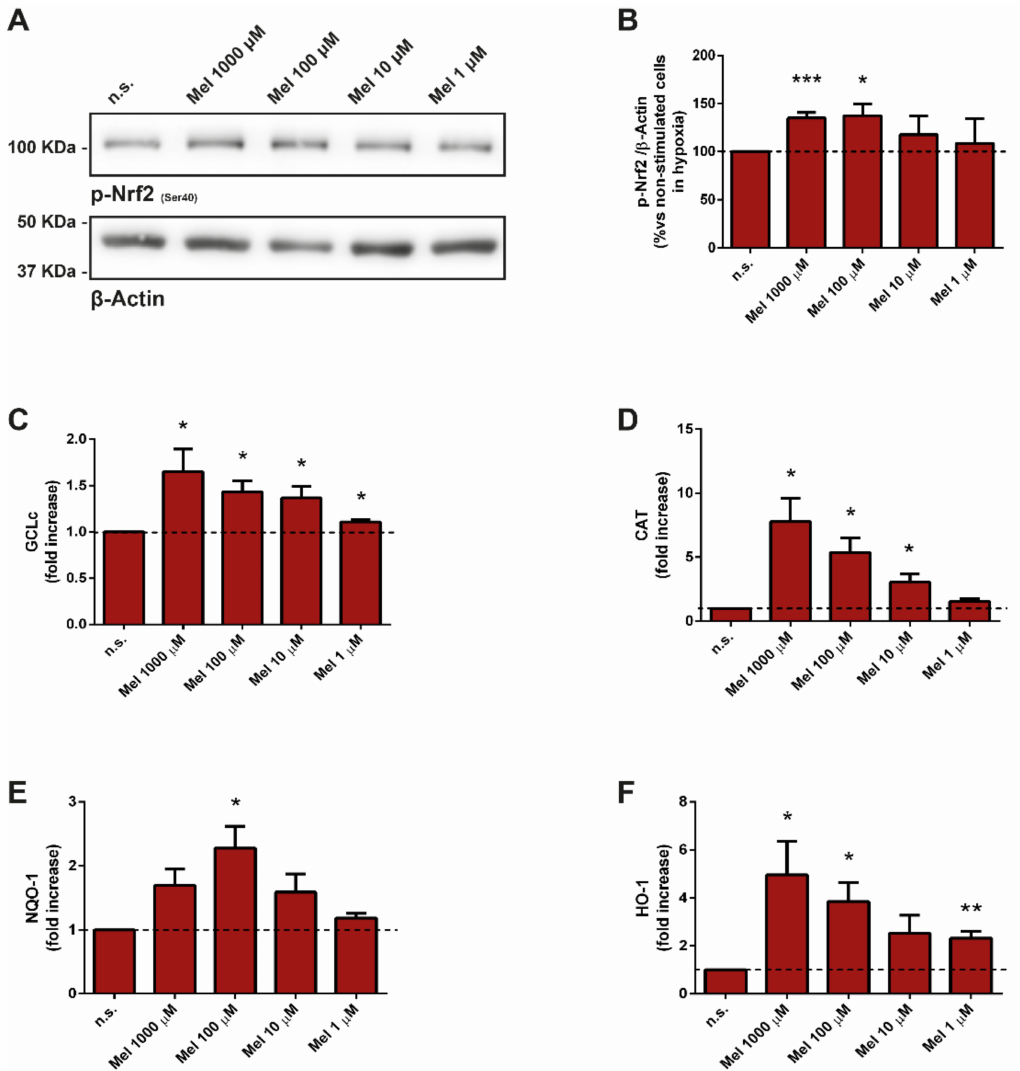
Figure 2. Effect of melatonin on Nrf2-phosphorylation and on Nrf2-regulated enzymes. PSC were incubated with melatonin (1000 µ M, 100 µ M, 10 µ M, or 1 µ M) during 4 h under hypoxia. ( A ) Blots showing the effect of melatonin on the phosphorylation of Nrf2. Western blotting analysis was carried out using a specific antibody against the protein. The levels of β -actin were employed as controls to ensure equal loading of proteins. ( B ) The bars show the quantification of protein phosphorylation. A horizontal dashed line represents the value observed in non-treated cells (n.s., incubated under hypoxia but in the absence of melatonin). Results are the mean ± S.E.M. of normalized values, expressed as % with respect to non-treated cells. Four independent experiments were carried out. ( C – F ) RT-qPCR analysis was used to study the effect of melatonin on the levels of various Nrf2-dependent antioxidant enzymes: Cysteine ligase-catalytic subunit ( A ; GClc ), catalase ( B ; CAT ), NAD(P)H quinone oxidoreductase 1 ( C ; NQO1 ), and heme-oxygenase-1 ( D ; HO-1 ). Gapdh mRNA was used for normalization. The bars show the fold increase of mRNA levels ± S.E.M. of each protein relative to non-treated cells (n.s., incubated under hypoxia but in the absence of melatonin). Three different preparations were used (n.s., non-stimulated cells; Mel, melatonin; *, p < 0.05; **, p < 0.01; and ***, p < 0.001 vs. non-treated cells in